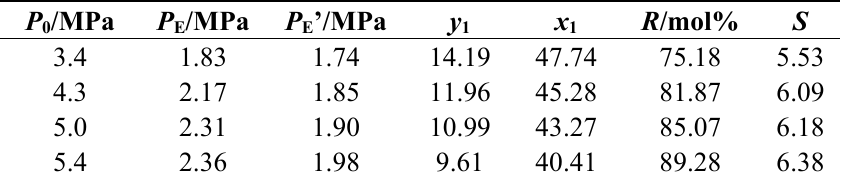
Table 2. Separation results for C 2 H 4 /CH 4 (30.08/69.92 mol%) in diesel-water emulsion with different initial pressure. Temperature, initial gas-liquid volume ratio, and water cut were specified to 274.15 K, 80, and 30 vol%, respectively.